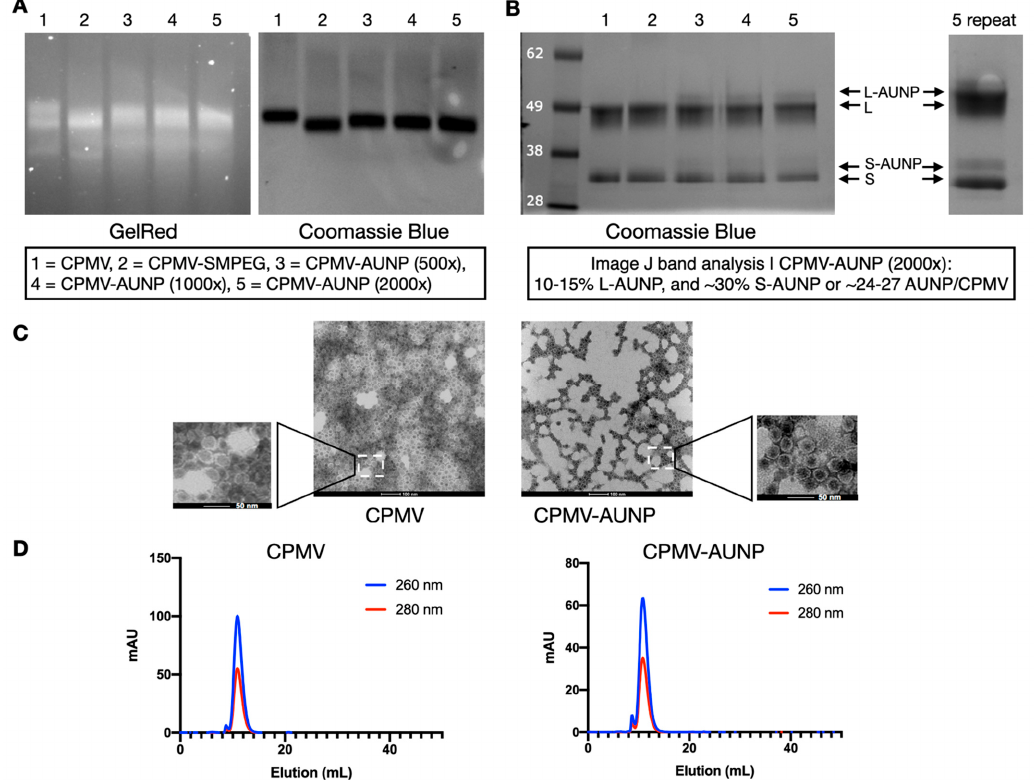
Figure 2. Characterization of CPMV-AUNP. ( A ) Agarose gel electrophoresis of CPMV, CPMV-SMPEG, and CPMV-AUNP stained for GelRed (RNA detection) and Coomassie Blue (protein detection) and imaged under UV and white light, respectively. ( B ) SDS-PAGE analysis of the denatured coat proteins, S and L of CPMV, as well as the AUNP-conjugated versions thereof. S and L proteins have a molecular weight of 24 kDa and 42 kDa, respectively, and SNTSESFGSGGGSGGC has a molecular weight of 1.3 kDa. The left lane shows the molecular weight of the See Blue Plus 2 protein marker. ( C ) TEM of negatively stained CPMV and CPMV-AUNP. The scale bars are 100 and 50 nm in the insets. ( D ) SEC using a Superose-6 increase column on the ÄKTA Explorer system; RNA is monitored using a 260 nm and protein is monitored at 280 nm detector.